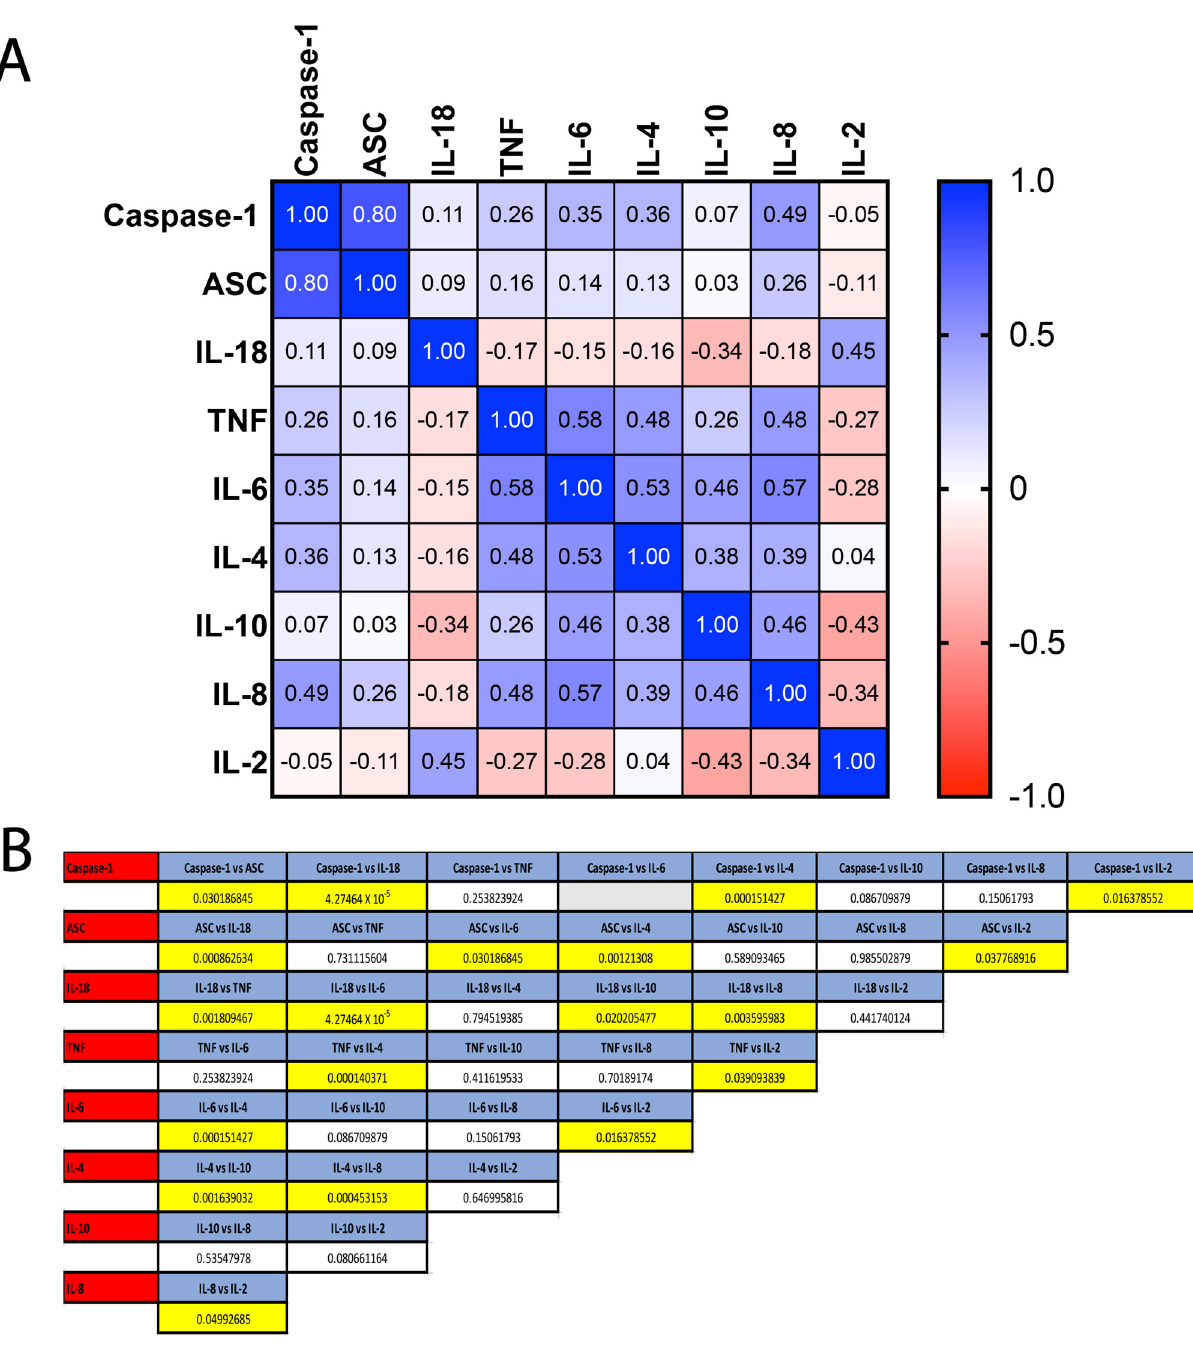
Figure 3. ROC Comparison among Inflammatory Biomarkers. ( A ) Correlation matrix using a Pearson correlation among inflammatory Biomarkers. ( B ) p -values of significance for the comparison among the inflammatory proteins analyzed: caspase-1, ASC, IL-18, TNF- α , IL-6, IL-4, IL-10 and IL- 8. ROC curve comparison analysis indicated that the ROC between caspase-1 and ASC ( p = 0.03), caspase-1 and IL-18 ( p = 4.27 × 10 − 5 ), caspase-1 and IL-4 ( p = 0.0001) as well as caspase-1 and IL-2 ( p = 0.01) were significantly different from each other (Figure 3B). Sim- ilarly, the ROC between ASC and other analytes differed from IL-18 ( p = 0.0009), IL-6 ( p = 0.03), IL-4 ( p = 0.001) and IL-2 ( p = 0.04). For IL-18, it also differed from TNF- α ( p = 0.002), IL-6 ( p = 4.27 × 10 − 5 ), IL-10 ( p = 0.02) and IL-8 ( p = 0.004). For TNF- α , the ROC curves also